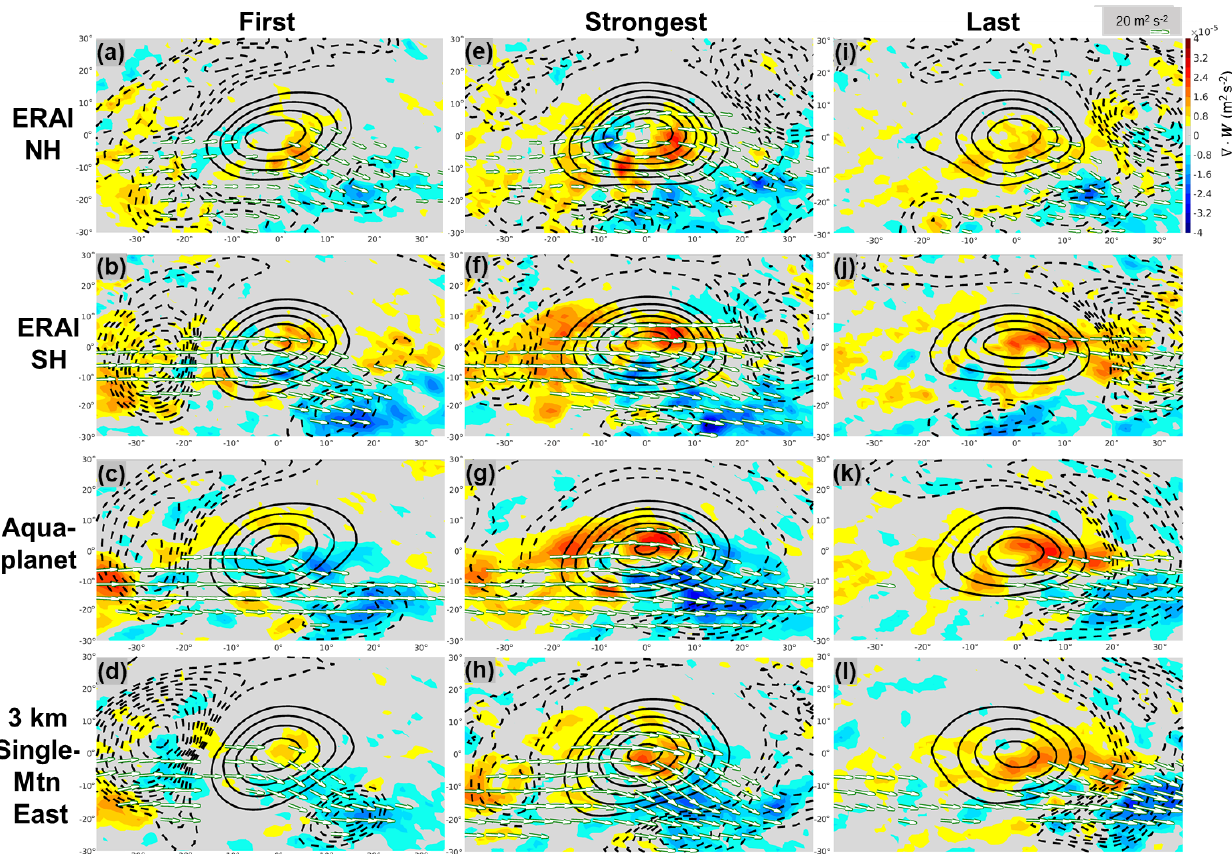
Figure 3. For cool-season blocking events, block-centered composites of positive 500hPa geopotential height anomalies (solid contours), negative 500hPa geopotential height anomalies (dotted contours), W (arrows), and ∇ · W (shading). (a, e, i) Computed with NH blocks over ocean in ERA-Interim. (b, f, j) Computed with SH blocks in ERA-Interim. (c, g, k) Computed with blocks in the aquaplanet integration. (d, h, l) Computed with blocks in the 3km single-mountain integration. The left, middle, and right columns are composites over the first, strongest, and last time steps of blocking episodes, respectively. Positive (negative) 500hPa geopotential height anomaly contours are in 50m ( − 10m) intervals with outer contour 50m ( − 30m); magnitudes less than 20m 2 s − 2 are removed. Latitude and longitude are defined relative to the composite block